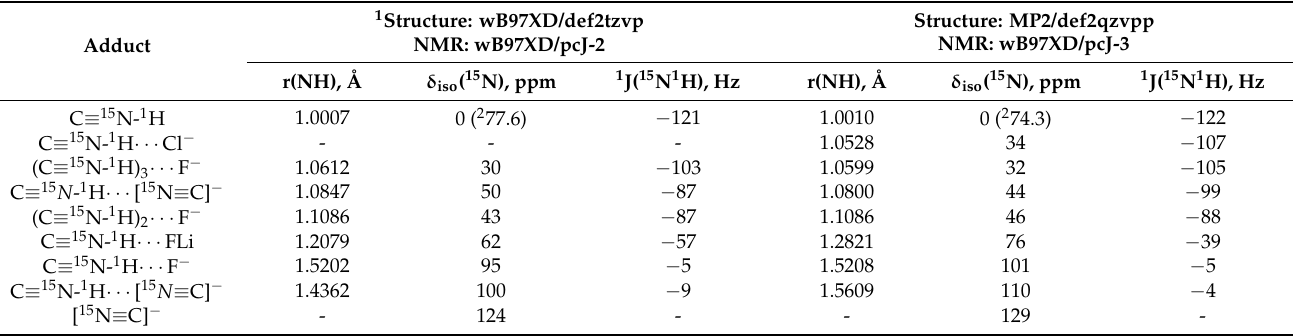
Table 1. The 15 N isotropic chemical shift, δ iso ( 15 N), referenced to free C ≡ 15 N- 1 H at 0 ppm and the 15 N- 1 N scalar coupling constant, 1 J( 15 N 1 H), as functions of the N-H distance in hydrogen-bonded complexes of C ≡ 15 N- 1 H obtained at different approximations and PCM = water.